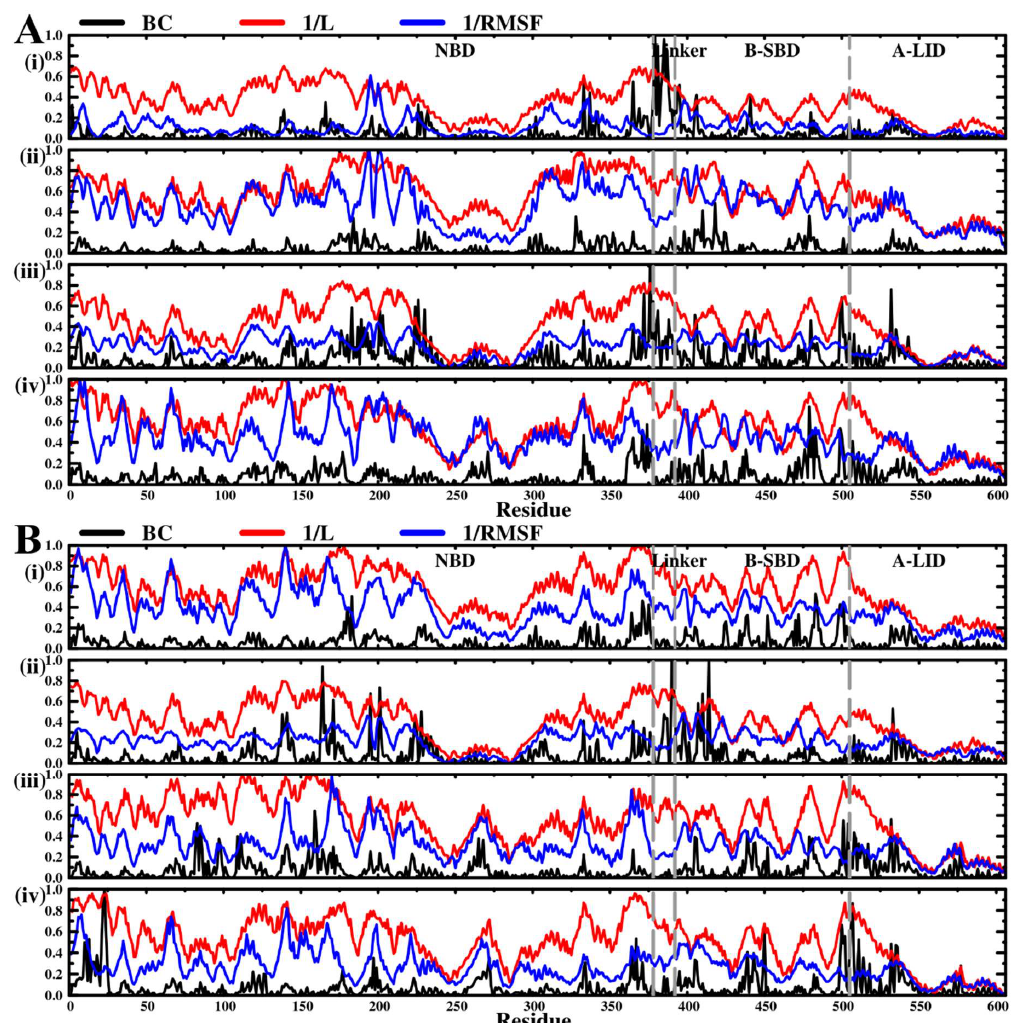
Figure 8. Graphical illustration of correlation between 1/RMSF, 1/Average L, and Average BC. ( A ) Hsp72 ( B ) Hsc70. Pairwise comparisons between 1/BC and 1/L as well as comparisons from duplicate trajectories are found in Supplementary Data (Figure S16 and Figure S17). A : ( i ) Hsp72 apo run1, ( ii ) Hsp72-SANC00132 complex run1, ( iii ) Hsp72 endo-apo run1, ( iv ) Hsp72 endo-complex run2. B : ( i ) Hsc70 apo run1, ( ii ) Hsc70-SANC00132 complex run1, ( iii ) Hsc70 endo-apo run1, ( iv ) Hsc70 endo-complex run1. Table 4. Pairwise comparison between BC, L −1 and RMSF −1 (100 ns and last 15 ns time frames) using Pearson’s correlation coefficient.